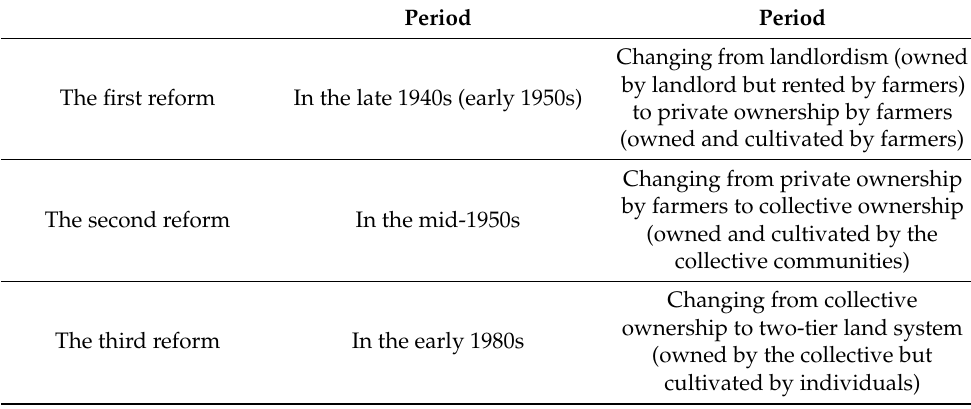
Table 1. Land system reform in China since the 20th